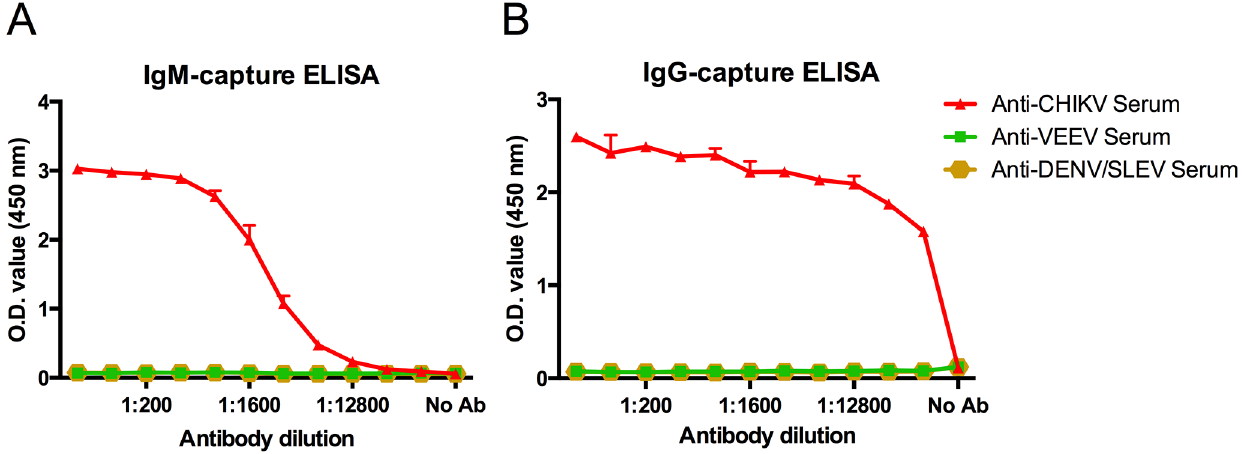
Fig 2. Human anti-CHIKV antibody-capture ELISAs utilizing EILV/CHIKV as antigen to detect either (A) IgM or (B) IgG antibodies (both measured over a range of serum dilutions, red). Human serum samples that were antibody-positive for either DENV or VEEV but negative for CHIKV by HI were included as negative controls. Mean and standard deviations of 2 replicates are